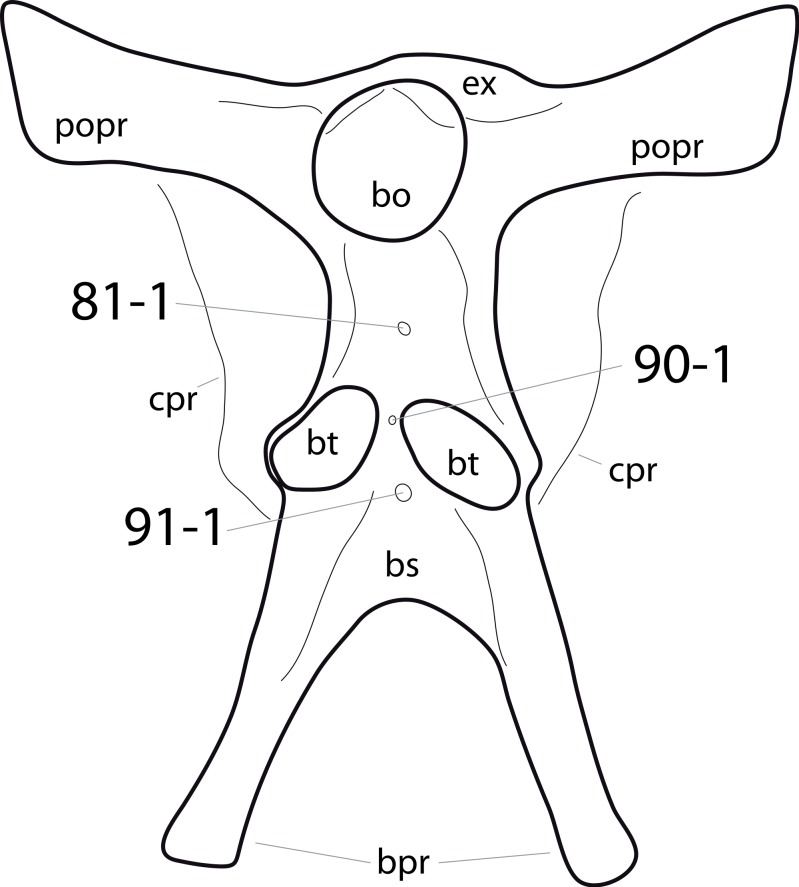
Hypothetical diplodocid basioccipital-basisphenoid complex in posteroventral view.Note the locations of pits sometimes present in diplodocid specimens: between occipital condyle and basal tubera (C81-1), in the notch between basal tubera (C90-1), and on the basisphenoid, between the bases of the basipterygoid processes (termed ‘basipterygoid recess’ by Wilson, 2002; C91-1). Abb.: bo, basioccipital; bpr, basipterygoid process; bs, basisphenoid; bt, basal tuber; cpr, crista prootica; ex, exoccipital; popr, paroccipital process.